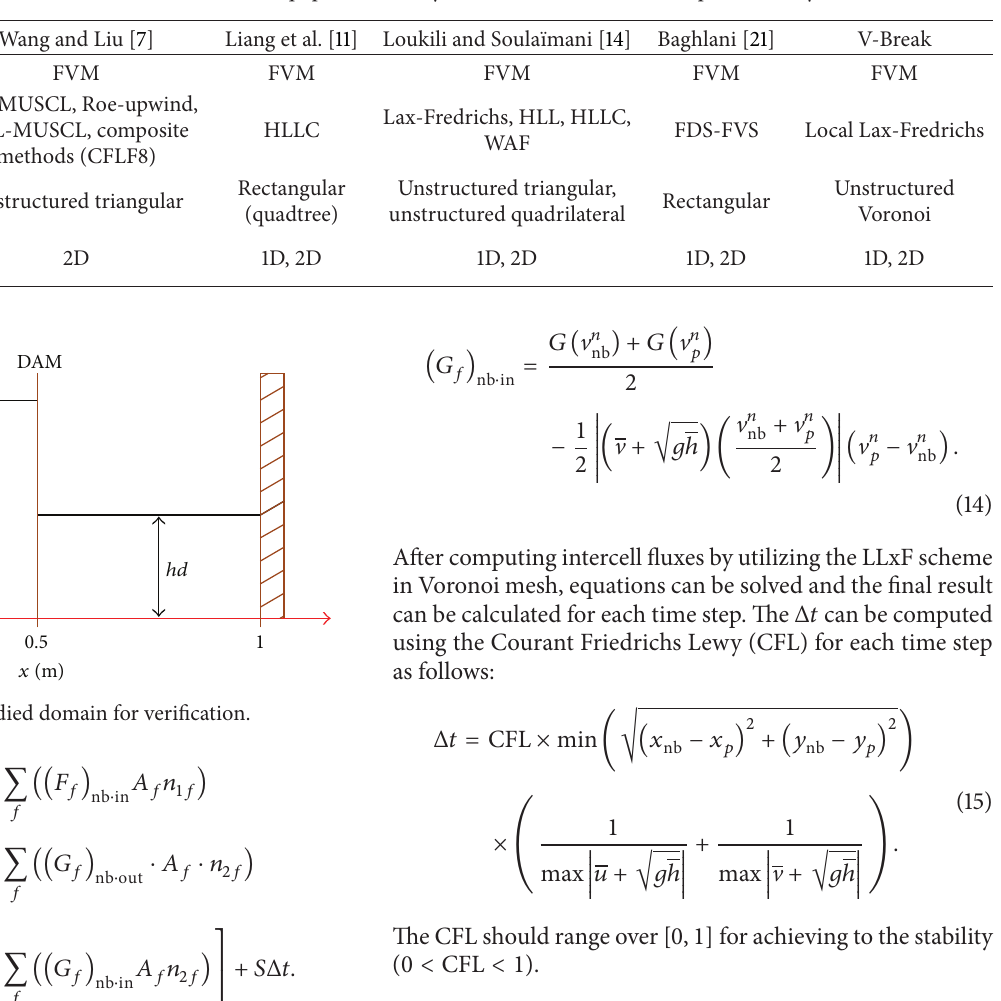
Table 1: General summarization of the equipment used by some other researchers and present study.